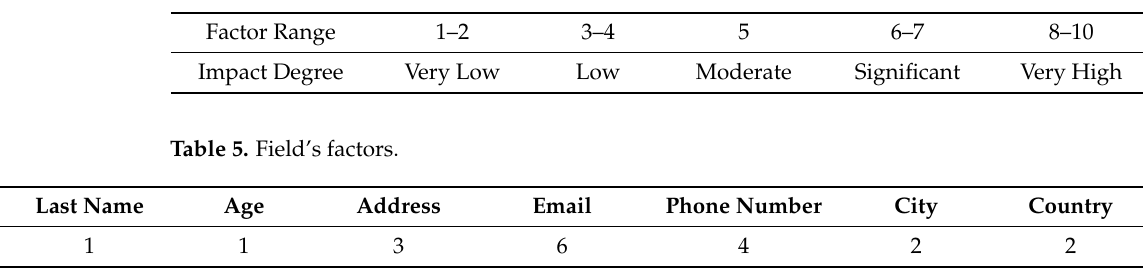
Table 4. Factor’s impact degree.